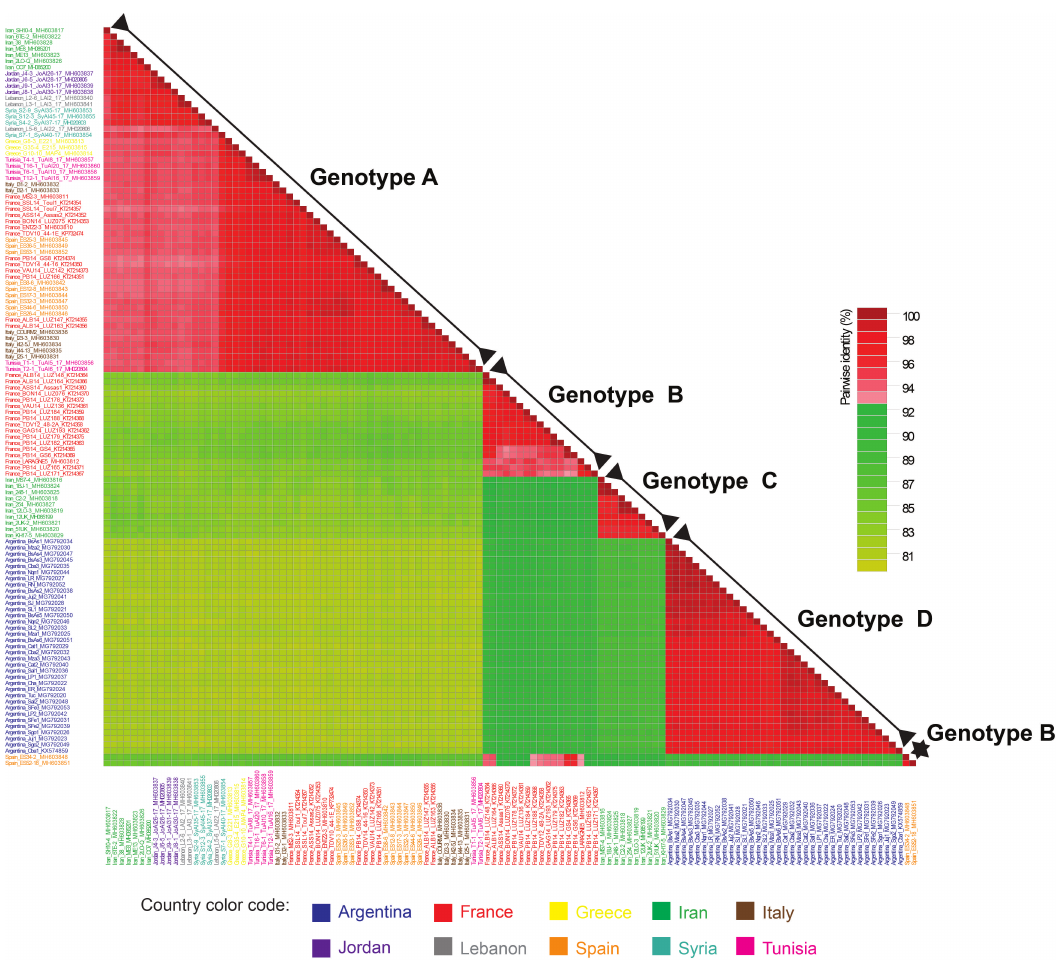
Figure 1. A “two-color” genome-wide pairwise identity matrix inferred using SDTv1.2 [23] showing that a tentative ALCV genotype demarcation threshold of 93% allows discrimination of the four ALCV genotypes (ALCV-A, ALCV-B, ALCV-C, and ALCV-D). Percent sequence identity is indicated by the color-coded